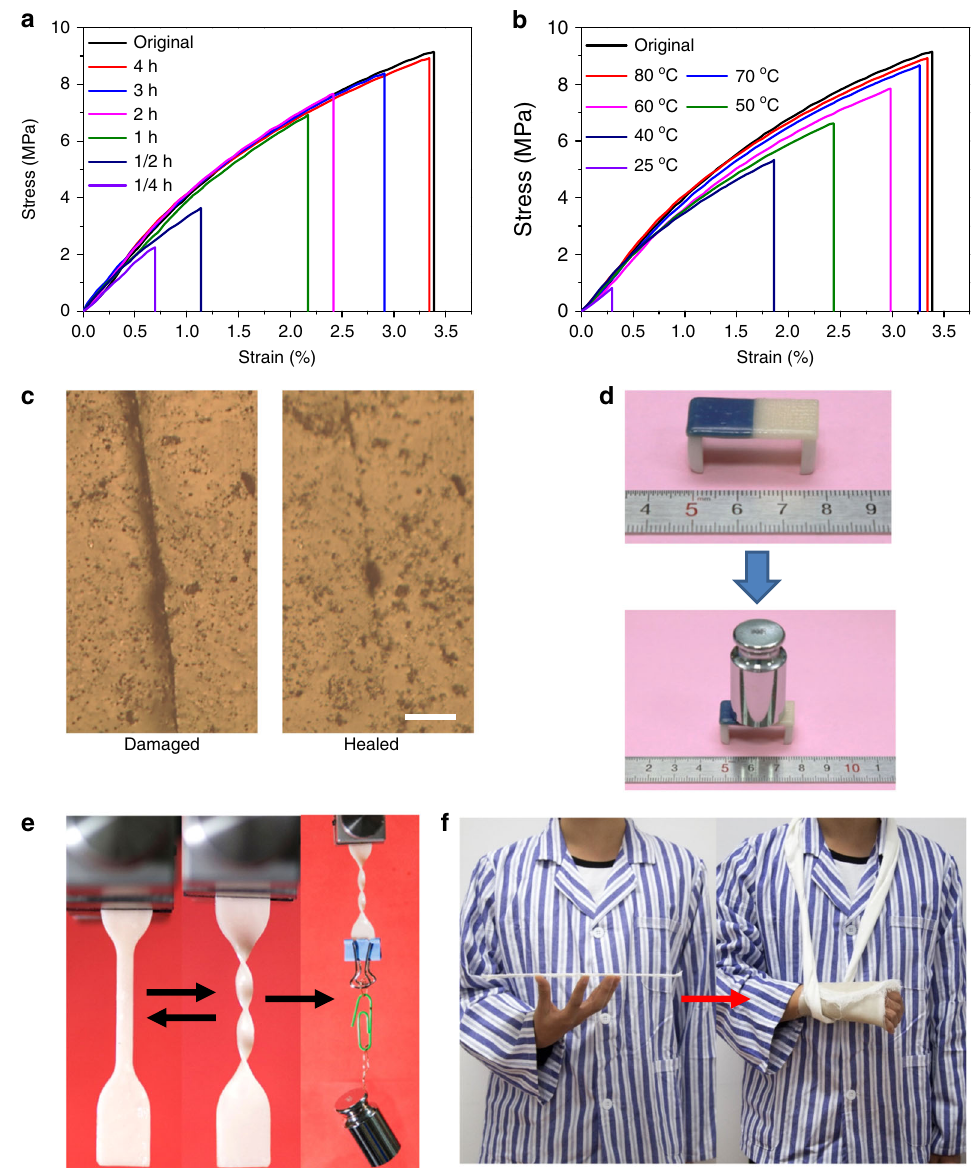
Fig. 3 Thermal healing and reshaping properties of PDMS-COO-Zn polymer. a Flexural stress-strain curves of PDMS-COO-Zn before and after healing at 80 °C for different time. b Flexural stress-strain curves of PDMS-COO-Zn before and after healing at different temperature for 4 h. c Microscopic images of a fi lm before (left) and after (right) healing at 80 °C for 4 h. Scale bar, 100 μ m. d The weight-bearing test of PDMS-COO-Zn polymer after healing. e A fusilli-shaped polymer made by local heating within tens of seconds can sustain a weight of 100 g immediately. f A rigid fl aky sample can be reshaped and adapted into an orthosis upon